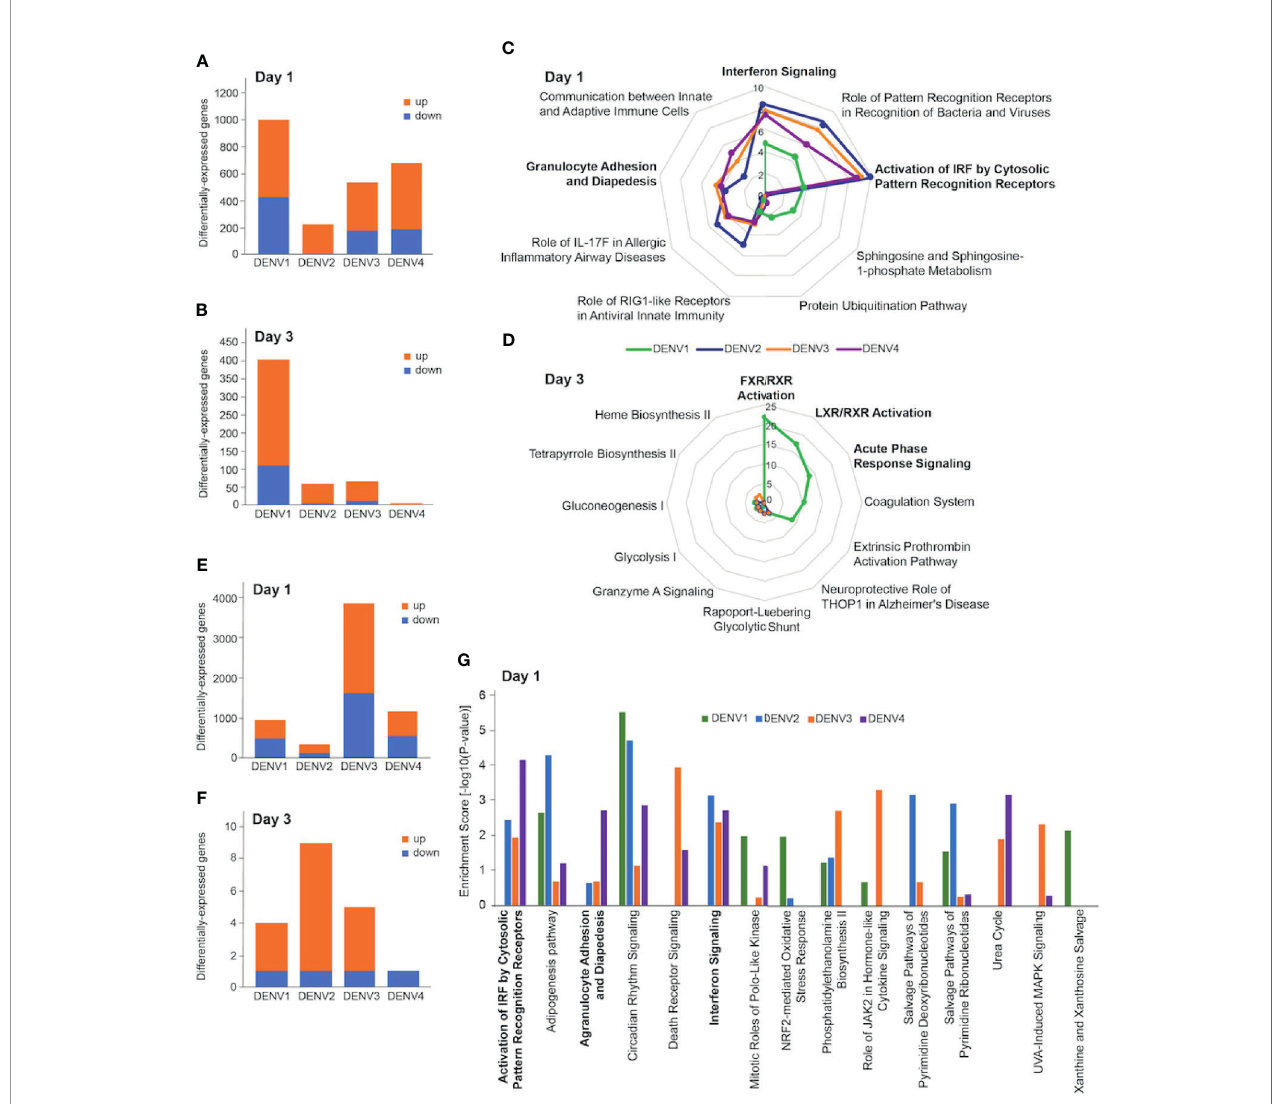
FIGURE 3 | Transcriptional pro fi ling of DENV-infected liver and spleen. Differentially-expressed genes (DEGs) in spleen (A, B) and liver (E, F) at day 1 (A, E) and day 3 (B, F) post infection with DENV1-4. Criteria used for differential expression analysis were an adjusted P value of <0.05, as determined by the limma empirical Bayes-moderated t test, and a log2FC of >0.58. DEGs were analyzed by IPA to produce lists of host pathways that were perturbed by the 4 serotypes. The top 5 enriched IPA canonical pathways in the spleen per DENV serotype on day 1 (C) and day 3 (D) are represented as radial plots. The distance from the center in each radial plot represents the enrichment score, which is de fi ned as -log10(p value), using a right-tailed Fisher exact test. The top 5 enriched Ingenuity canonical pathways in the liver per DENV serotype on day 1 (G)